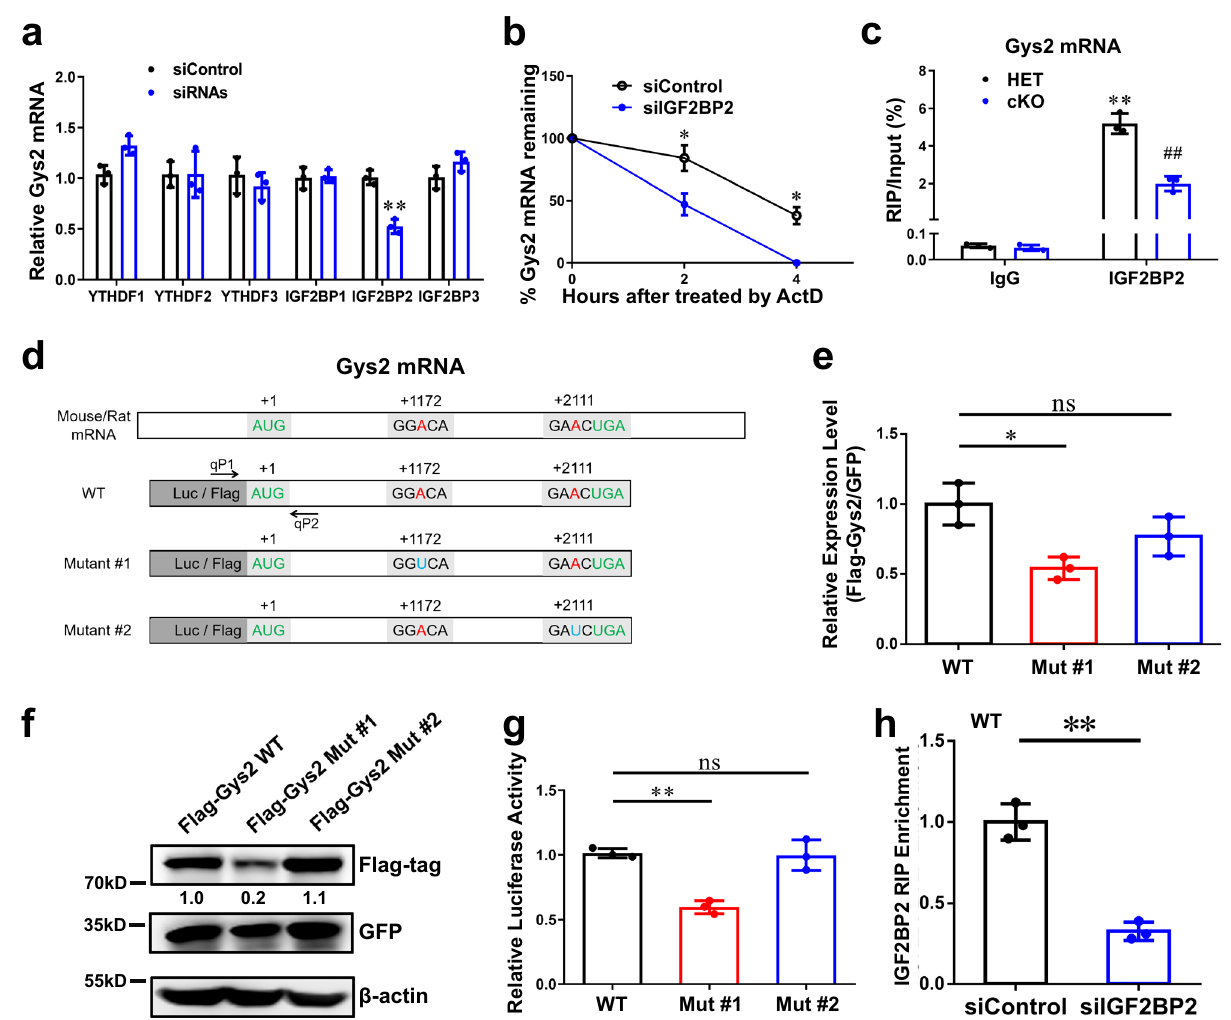
Fig. 4 | N6-methyladenosine stabilizes Gys2 mRNA in an IGF2BP2-dependent manner. a qRT-PCR assay of relative Gys2 mRNA level ( β -actin as reference) in siControl and indicated siRNAs. n =3 independent experiments. ** p <0.01 com- paring with IGF2BP2:siControl. b qRT-PCR assay of Gys2 mRNA stability ( β -actin